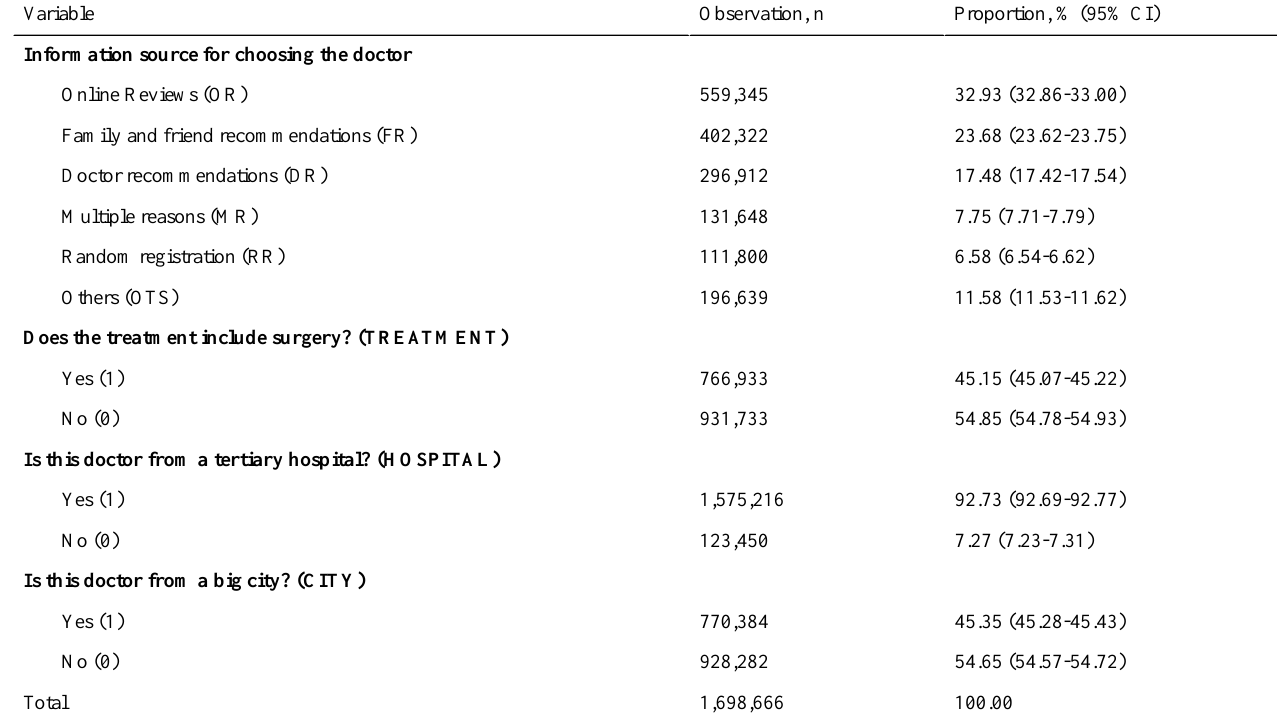
Table 1. Descriptive statistics of variables.